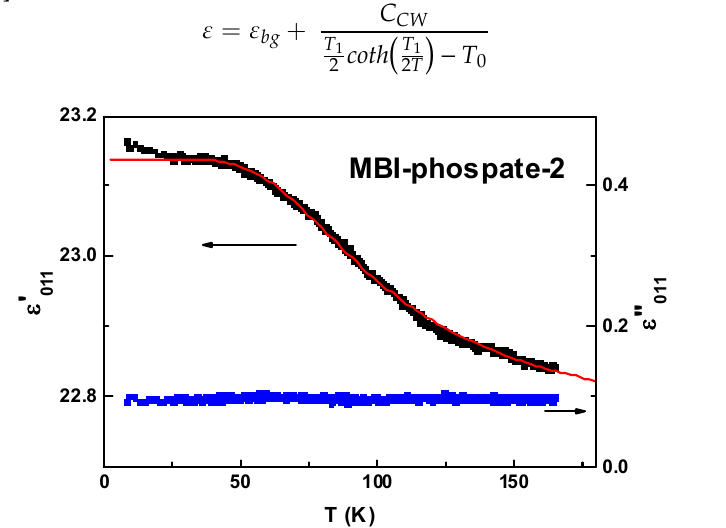
Figure 14. Temperature dependence of real and imaginary parts of dielectric constant at f = 10 kHz in MBI-phosphate-2. Line shows fitting using Barrett formula.